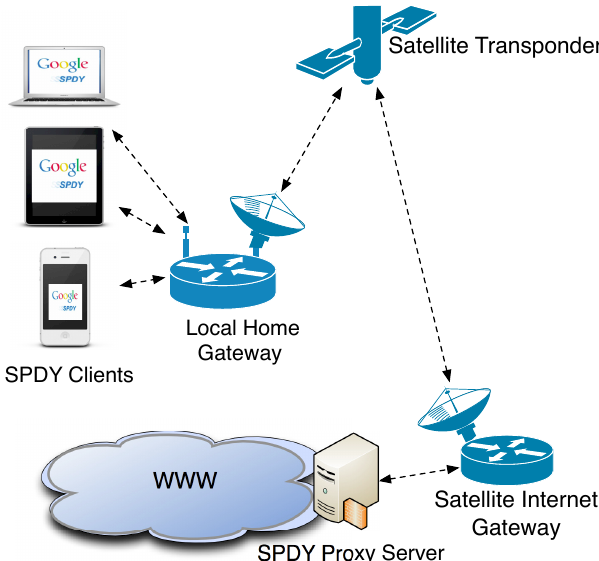
Figure 1. Reference architecture of the adopted tested. The satellite link has been emulated with different values of RTT and packet